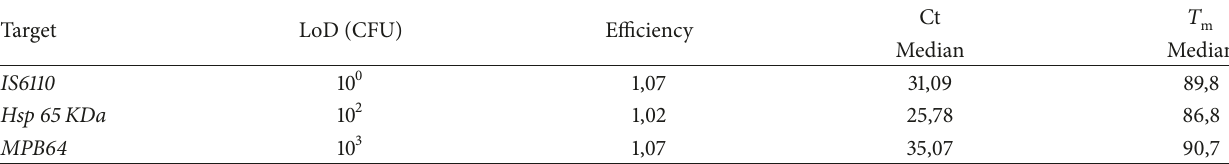
Table 6: LoD, efficiency, Ct, and Tm results for real time